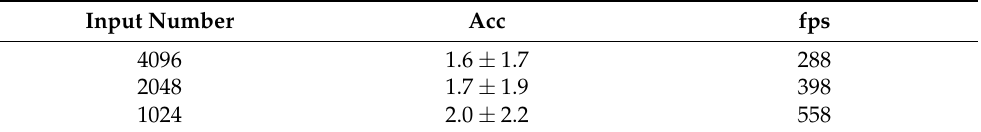
Table 4. Comparison of results achieved by different methods on the Biwi Kinect Head Pose dataset.